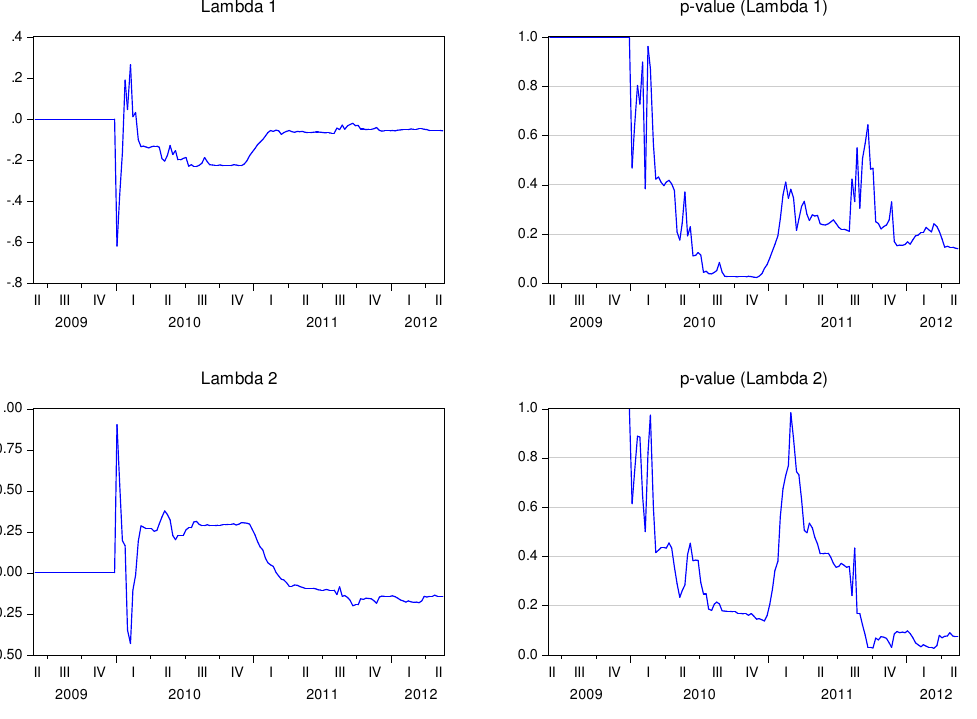
Figure 5. Recursive estimation of the speed adjustment parameters — The Netherlands.